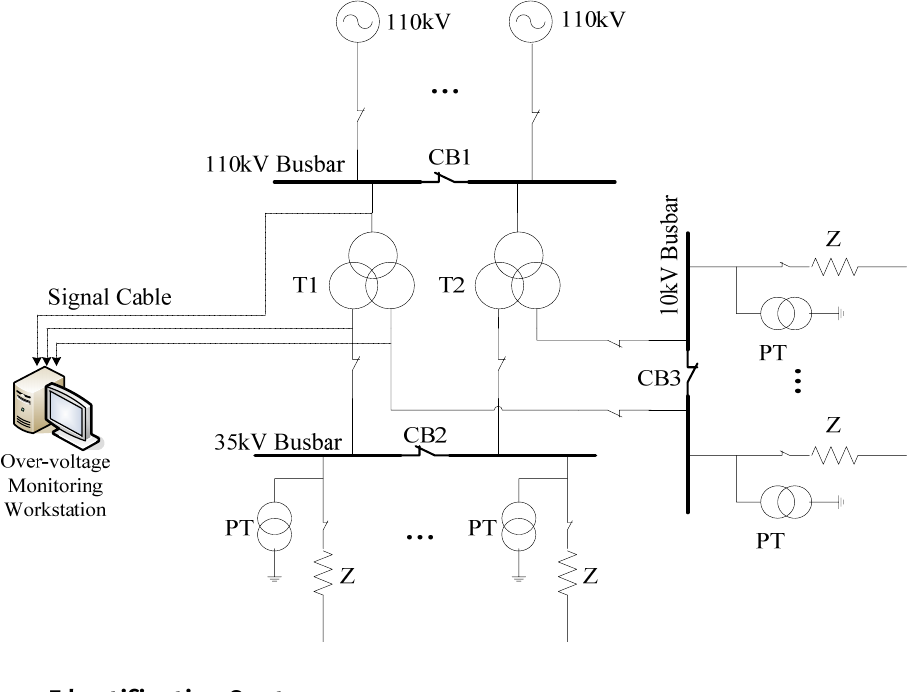
Figure 3. Wiring diagram of monitoring system in the